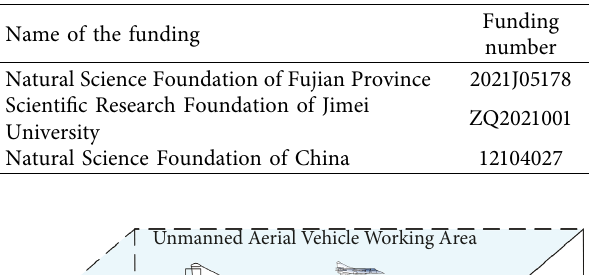
Table 1: Funding statement.